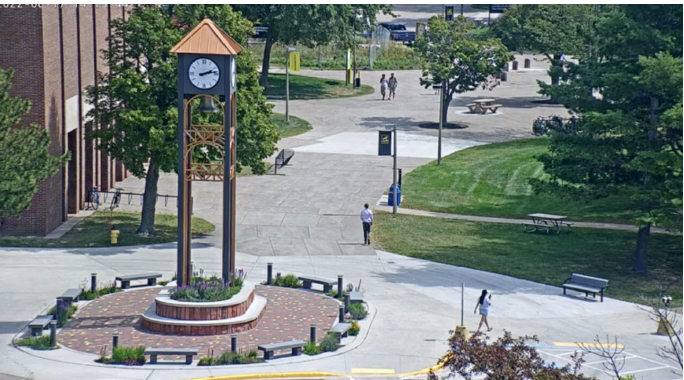
Figure 1. Clock tower